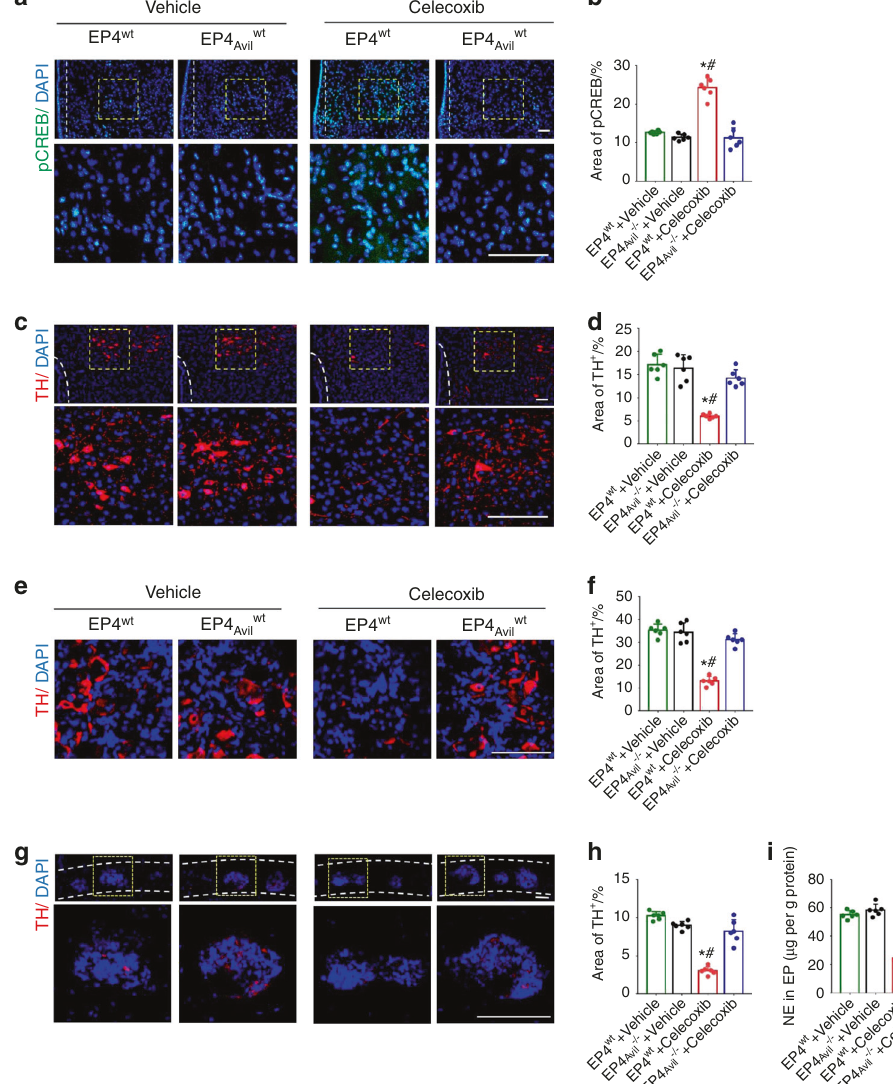
Fig. 6 Knockout of the EP4 receptor in the sensory nerves in fl uenced the effect of low-dose celecoxib on pCREB expression in the VMH and TH expression in the PVN, cervicothoracic ganglion and endplate. a Representative images of immunostaining of pCREB (green) and DAPI (blue) in hypothalamic VMH in the EP4 wt or EP4 Avil − / − mice at 2 weeks after celecoxib or vehicle treatment. b Quantitative analysis of the pCREB + area in the VMH. c Representative images of immunostaining of TH (red) and DAPI (blue) in the hypothalamic PVN in the EP4 wt or EP4 Avil − / − mice at 2 weeks after celecoxib or vehicle treatment. d Quantitative analysis of the TH + area in the PVN. e Representative images of immunostaining of TH (red) and DAPI (blue) in the cervicothoracic ganglion of the EP4 wt or EP4 Avil − / − mice at 2 weeks after celecoxib or vehicle treatment. f Quantitative analysis of the TH + area in the cervicothoracic ganglion. g Representative images of immunostaining of TH (red) and DAPI (blue) in the endplates of the EP4 wt or EP4 Avil − / − mice at 2 weeks after celecoxib or vehicle treatment. h Quantitative analysis of the TH + area in endplates. i ELISAs of norepinephrine concentration in lumbar endplates in the EP4 wt or EP4 Avil − / − mice at 2 weeks after celecoxib or vehicle treatment. Scale bars, 50 μ m ( a, c, e, g ). * P < 0.05 compared with the sham group and # P < 0.05 compared with the vehicle group at the corresponding time points. n = 6 per group ( b , d , f , h , i